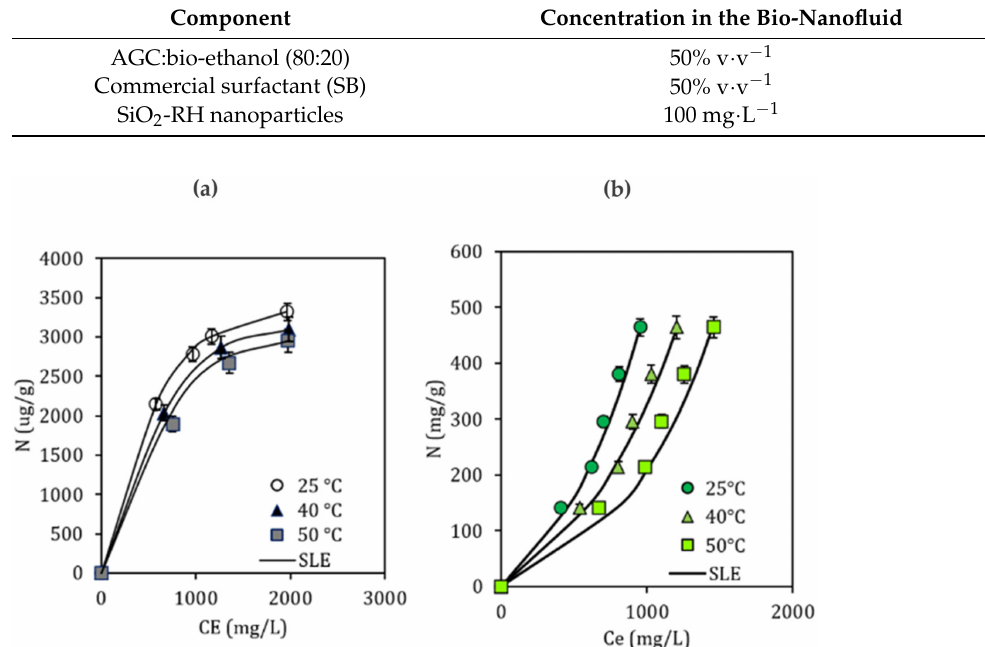
Figure 12. ( a ) Adsorption isotherms of bio-nanofluid onto Ottawa sand at 25, 40, and 50 ◦ C. ( b ) Adsorption isotherms of bio-fluid onto SiO 2 -RH nanoparticles at 25, 40, and 50 ◦ C. The symbols represent the experimental data with respective error bars of standard deviation. The continuous line represents the SLE model